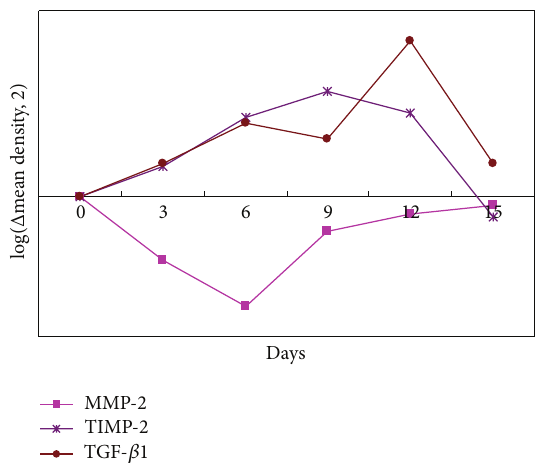
Figure 4: Dynamic changes of the protein expression of MMP- 2, TIMP-2, and TGF- 𝛽 1 before and within 15 days after the APG application. Dynamic changes of the MMP-2, TIMP-2, and TGF- 𝛽 1 before and within 15 days after the first APG